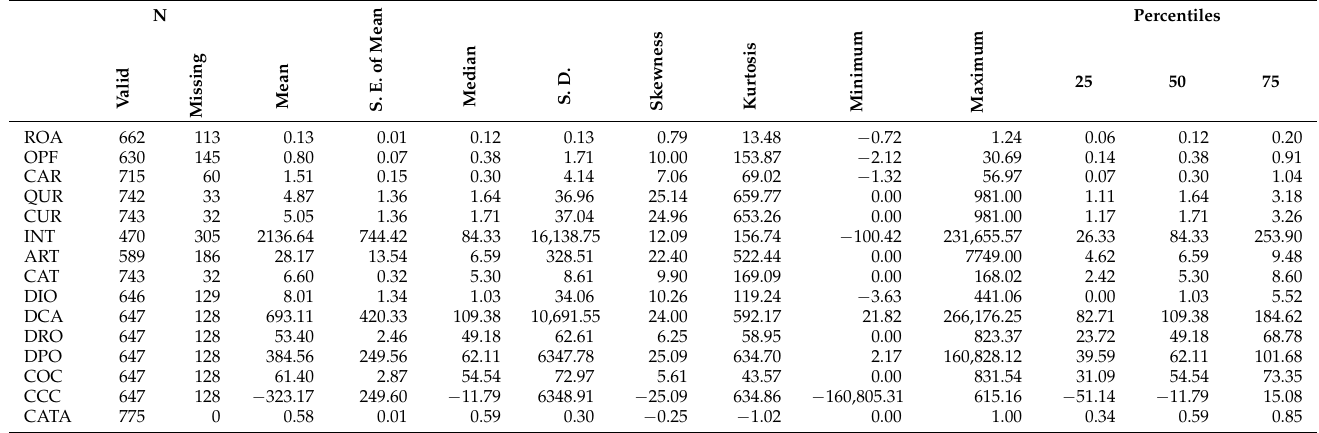
Table 5. Descriptive statistics for transport companies in the Czech Republic.